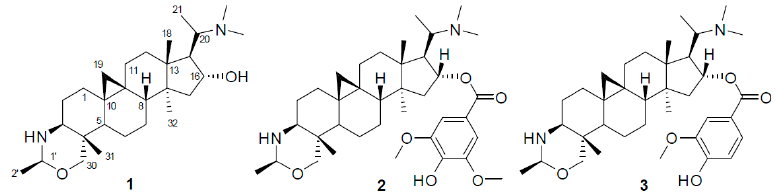
Figure 1. Chemical structures of compounds 1 – 3 .